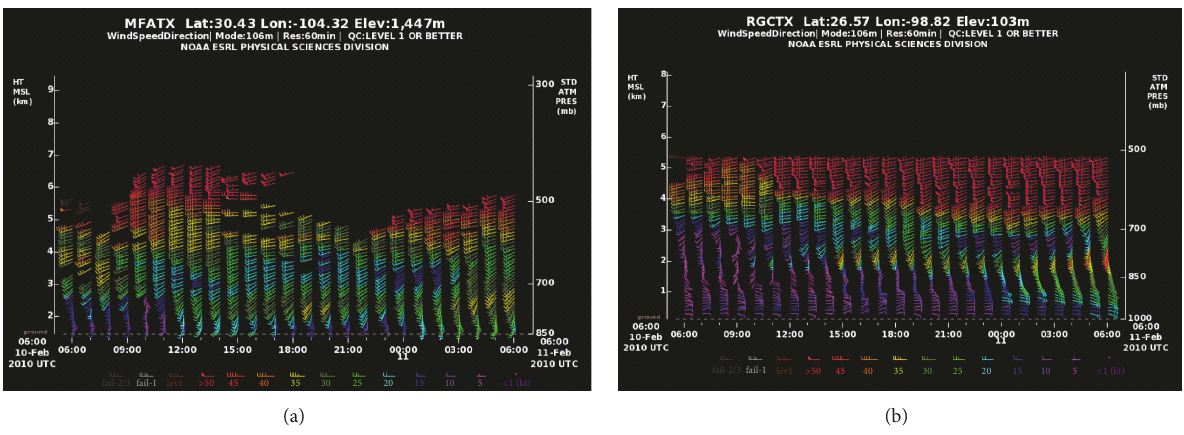
Figure 9: NOAA wind profilers (in knots) for (a) Marfa, Texas, and (b) Rio Grande City, Texas, valid from 0600 UTC 10 February to 0600 UTC 11 February